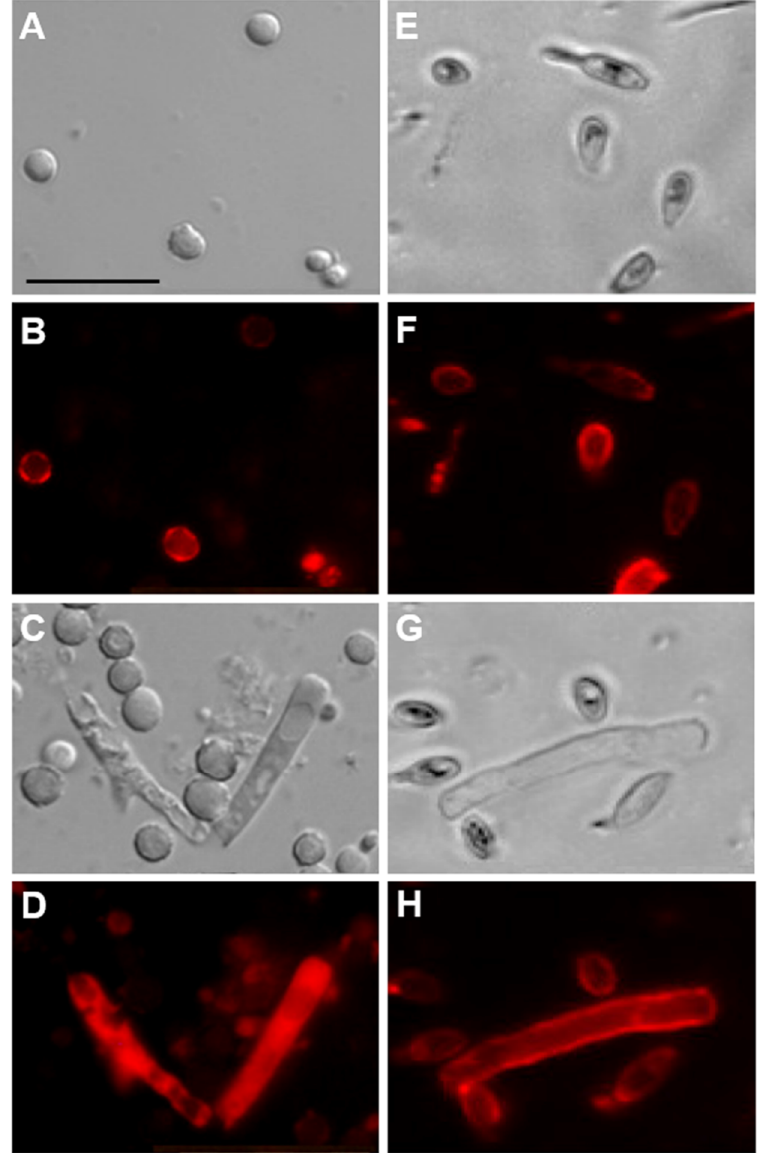
Figure 5. Distribution of GlcCer species on Cladosporium species’ surface. The anti-GlcCer Mab revealed the presence of GlcCer species on the surface of conidia and mycelium from C. herbarum ( B , D ) and C. resinae ( F , H ). ( A , C , E , G ) show the images of differential interferencial contrast microscopy (DIC). Bar: 20 µm.